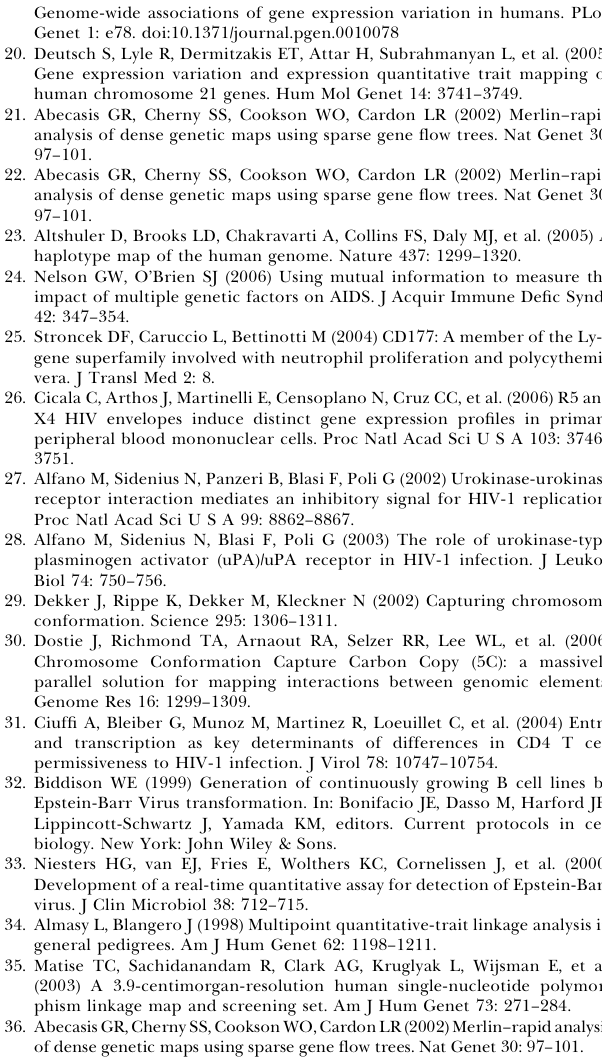
Figure S2. Expression and Heritability of HIV-1 Susceptibility Trait in CEPH Families (A) Heritability estimate ( h 2 ) for eight study traits (percent of positive cells and mean fluorescence intensity, MFI), and for the EBV copy number (** p , 0.001, *** p , 0.0001). (B) Representation of interindividual (black dots), and interfamily (red bar ¼ median value for each family) differences in percentage of GFP-positive cells after transduction with a HIV.GFP of 198 lymphoblastoid B cell lines from 15 CEPH pedigrees. Found at doi:10.1371/journal.pbio.0060032.sg002 (68 KB PPT). Figure S3. Genome Scan and Fine Mapping of CD39 Expression (MFI Trait) (A) Results of linkage analysis with 15 families. A single locus on HSA10q23 (rs766083) is significant after correction by permutation analysis ( n ¼ 500). (B) Results of association analysis in 56 independent individuals using SNPs from the HapMap project. All SNPs in a 700 kb region surrounding the CD39 gene were used. rs numbers next to peaks indicate significant SNPs after correction for multiple testing. Found at doi:10.1371/journal.pbio.0060032.sg003 (94 KB PPT). Figure S4. Chromosomal Localization of rs2572886 The SNP is localized in an intergenic region containing genes belonging to the LY6/uPAR family. The figure shows images generated through the University of California at Santa Cruz genome browser and Haploview software.